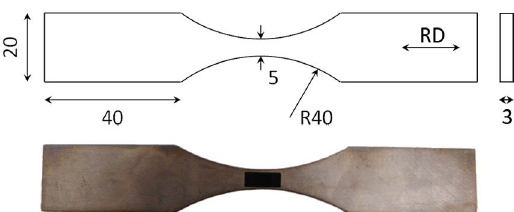
Figure 1. Illustration of the test specimen (dimensions in mm) and photograph of a treated sample. RD refers to the rolling direction.